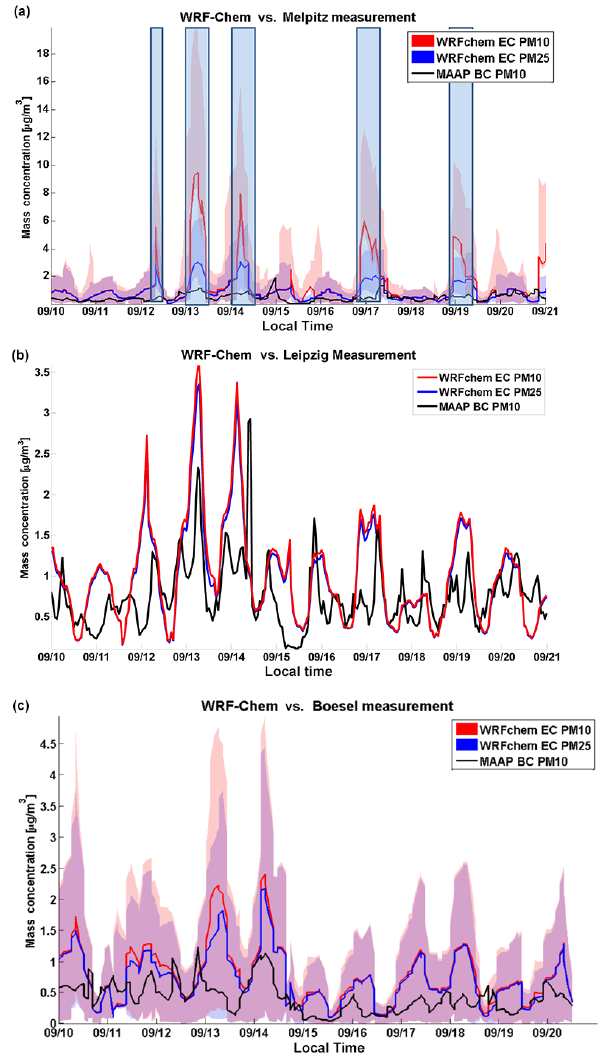
Figure 4. The comparison of EC/BC concentration between model and MAAP measurements. Red line: EC concentration in PM 10 of model result; blue line: EC concentration in PM 2 . 5 of model re- sult; black line: BC concentration in PM 10 of MAAP measurement, used as the best approximation of EC. The shaded areas indicate the model uncertainty defined by the maxima (upper limit of the shade) and minima (lower limit of the shade) values within 12km dis- tance from Melpitz/Bösel. The blue rectangles mark the EC plume episodes at Melpitz. (a) Melpitz: modelling result derived from D04 simulation with 2km resolution; (b) Leipzig-TROPOS: modelling result derived from D04 simulation with 2km resolution; (c) Bösel: modelling result derived from D03 simulation with 6km resolution.